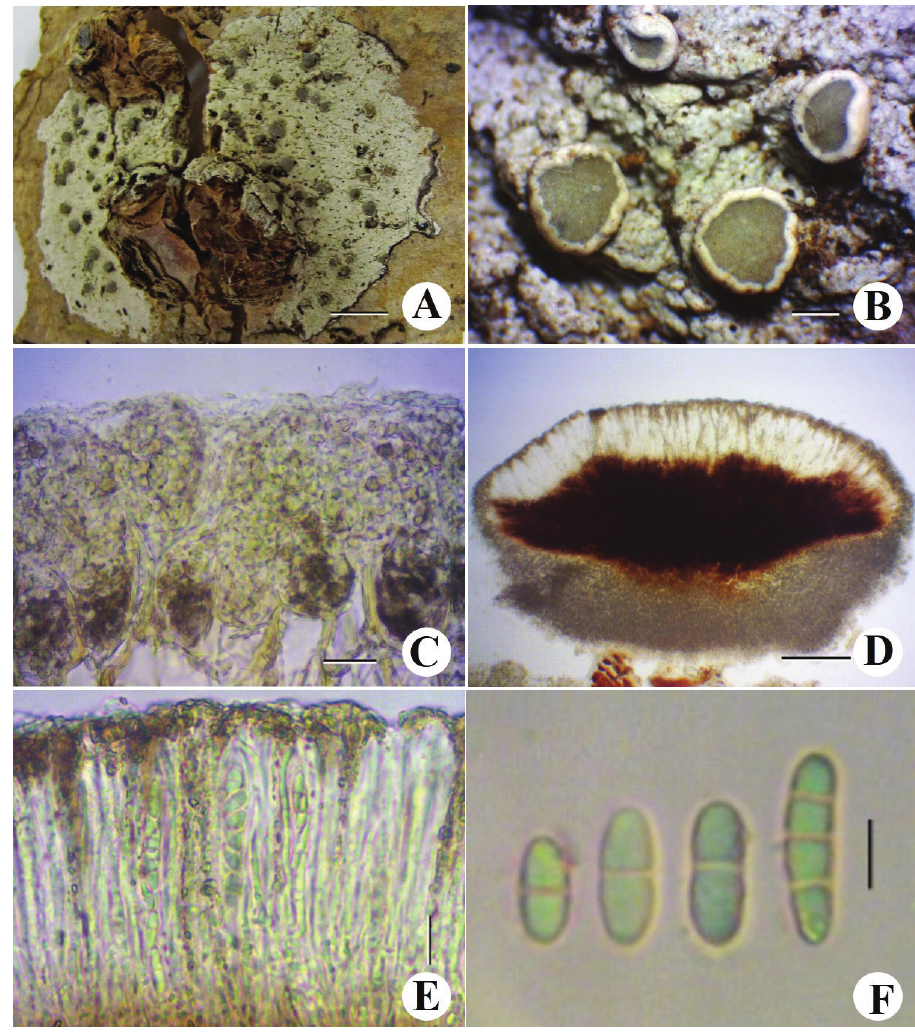
Figure 1. Morphology and anatomy of Kalbionora palaeotropica , A–B habit C cross-section through thallus showing cortex and algal layer D cross-section through apothecium showing dark brown hypothe- cium E hymenium, and F transversely septate ascospores (holotype). Scale bars: 0.5 cm ( A, B ), 20 µm ( C ), 0.1 mm ( D ), 10 µm ( E ), 5 µm ( F